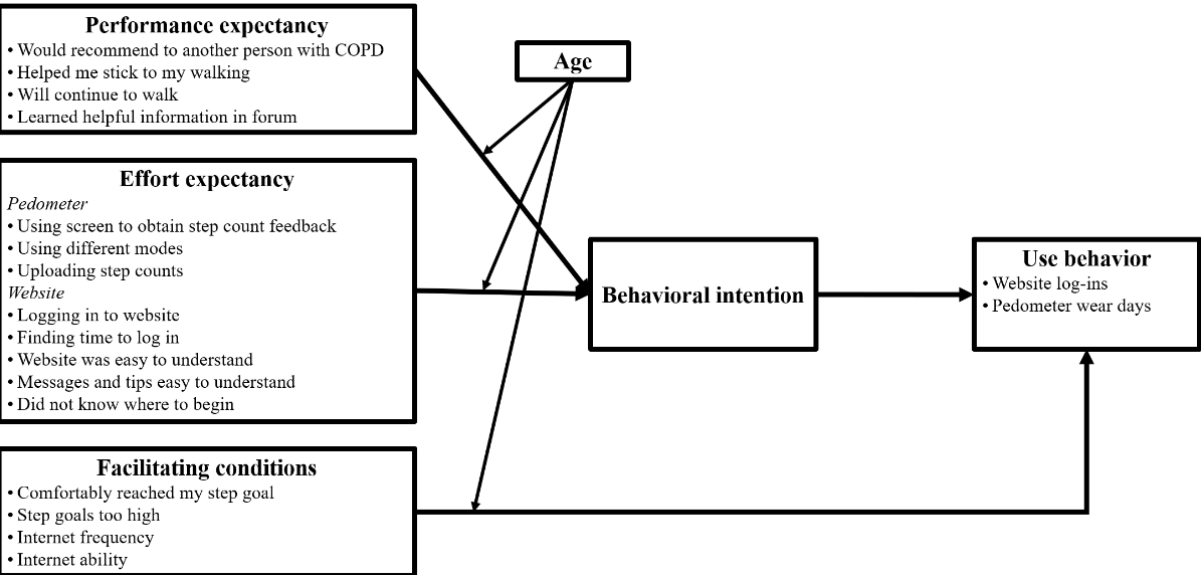
Figure 1. Conceptual framework of the unified theory of acceptance and use of technology, modified to represent the current study and the corresponding items assessed. COPD: chronic obstructive pulmonary